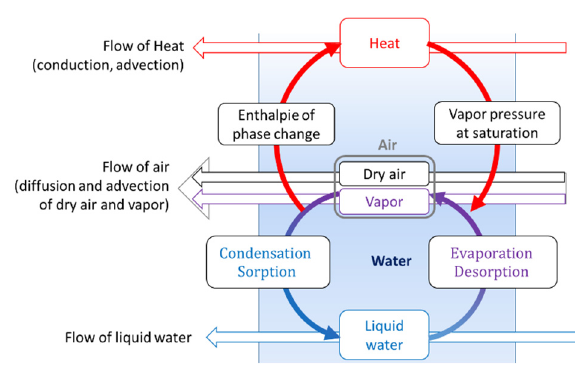
Figure 2. Diagram of heat and moisture transfers within an earthen